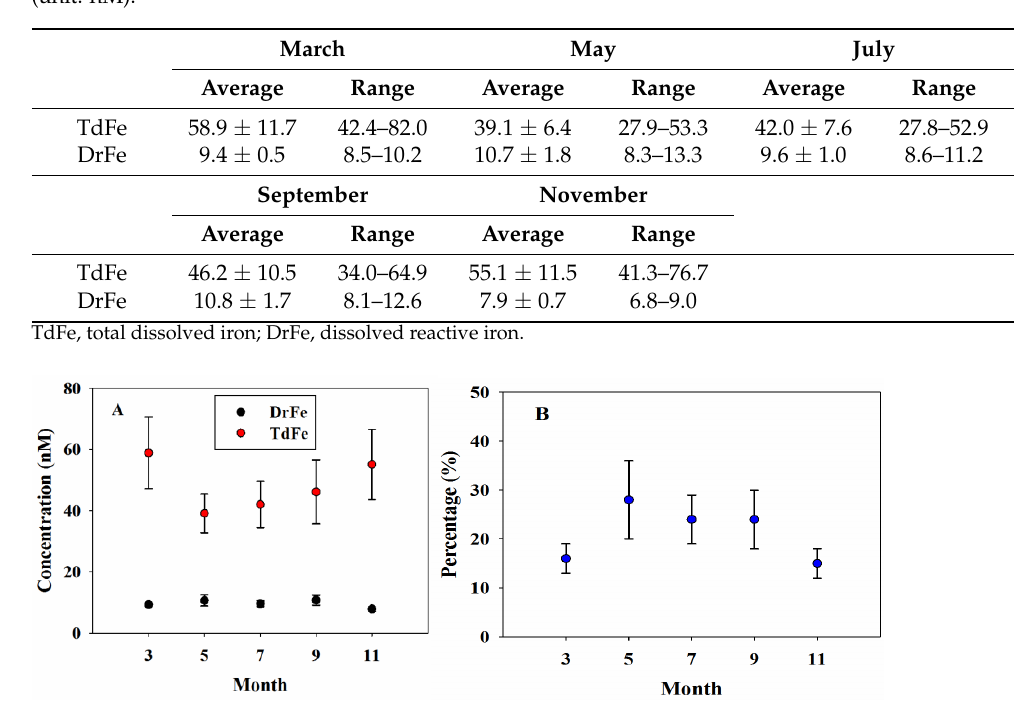
Figure 3. ( A ) Temporal distribution of dissolved reactive iron (DrFe) and total dissolved iron (TdFe) in Sishili Bay in 2018 (nM, monthly average values); ( B ) Variation trend of the proportion of DrFe to TdFe.